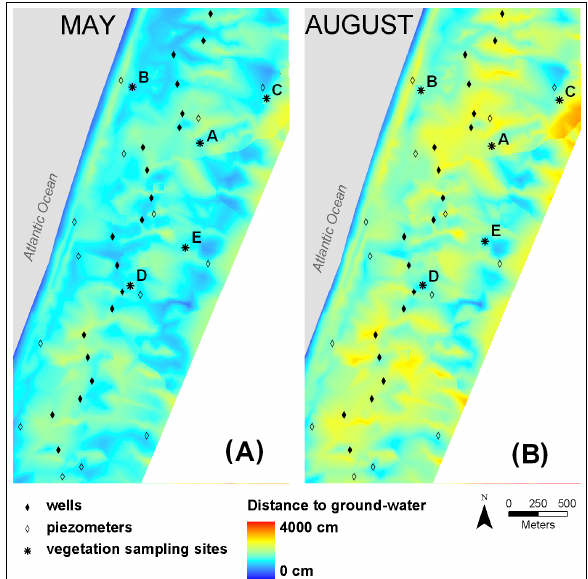
Fig. 4. Maps indicating the depth to groundwater calculated from measurements at wells and piezometers in (A) spring and (B) sum- Figure 4. Maps indicating the depth to groundwater interpolated from measurements at 3 mer 2005. wells and piezometers in (A) spring and (B) summer 2005. 4